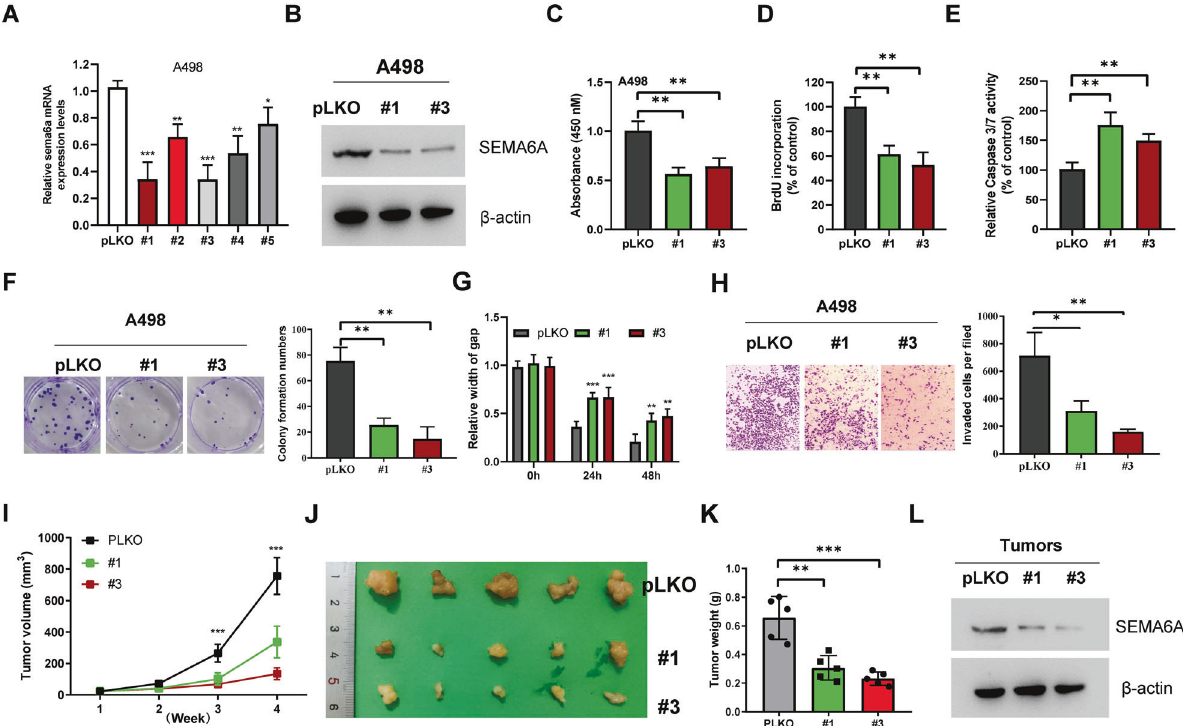
Fig. 4 Depletion of SEMA6A inhibits ccRCC malignancy both in vitro and in vivo. A Relative expression levels of SEMA6A mRNA in A498 cells transfected with indicated shRNAs. * p < 0.05, ** p < 0.01, *** p < 0.001. B Western blot analysis of SEMA6A protein in A498 cells stably expressing indicated shRNAs. C Proliferation ability of A498 cells from B was determined by CCK-8 assay. ** p < 0.01. D Relative number of BrdU- incorporated cells in A498 cells from B . ** p < 0.01. E Relative Caspase3/7 activity in A498 cells from B ** p < 0.01. F Colonies of A498 cells from B . * p < 0.05, ** p < 0.01. G Migration ability of A498 cells from B . ** p < 0.01, *** p < 0.001. H Invasion ability of A498 cells from B . ** p < 0.01, *** p < 0.001. I – L A498 cells stably expressing indicated shRNAs were injected subcutaneously into 6-week-old male nude mice ( n = 5), and tumor growth curves were drawn weekly ( I ). After 4 weeks, mice were sacri fi ced by cervical dislocation. Then, the tumors were removed, photographed ( J ), weighed ( K ), and subjected to Western blot analysis to detect SEMA6A expression ( L ). ** p < 0.01, *** p <